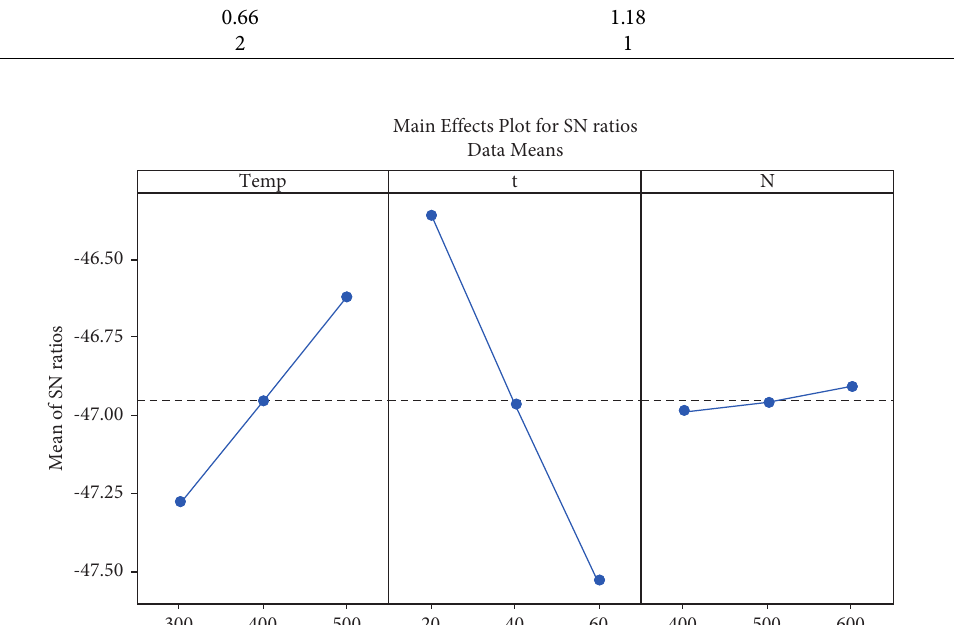
Figure 10: Significant consequence diagram based on the SN ratio for porosity and compressive strength (temp: temperature in ° C; t : time in sec; N : stir speed in rpm).